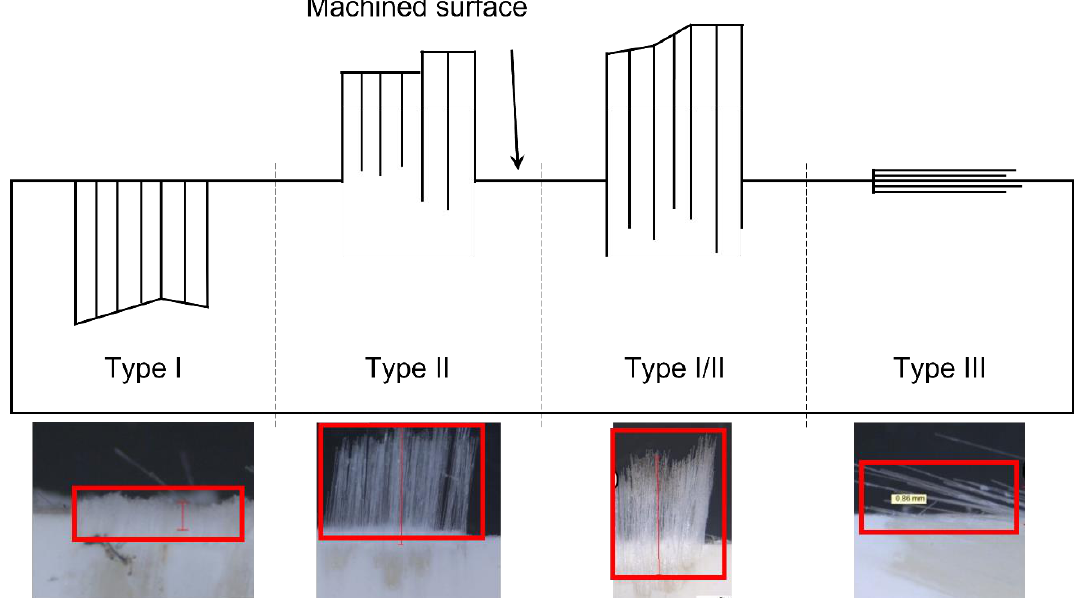
Figure 1. Schematic representation of the four delamination types with examples of the actual defects of each type.